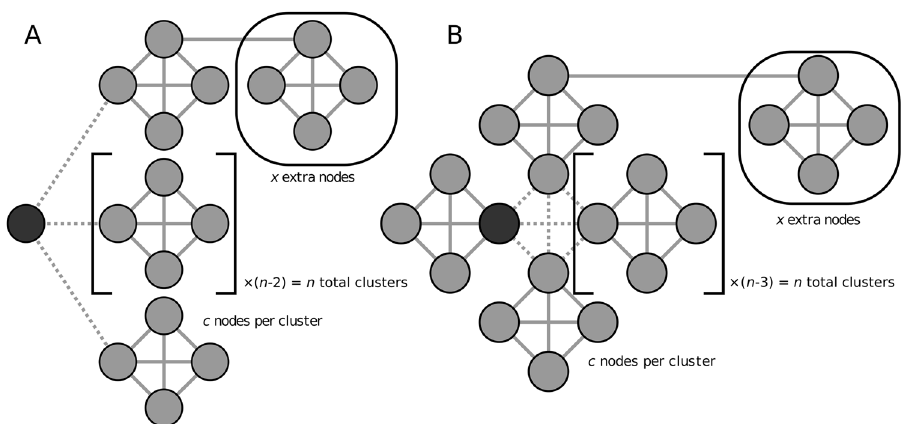
Figure 2. Test networks for evaluation of candidate versatility metrics. ( A ) The n-split case. An indicator node (coloured darker) can be affiliated with exactly one of the n clusters with probability 1/ n . ( B ) The n-clusters case. There are n clusters each with a probability p of connecting to any other given cluster. The indicator node is a member of one of these clusters which is weakly connected to other clusters. In both cases clusters are of size c , and these cases are assumed to be a part of a larger network, with x other